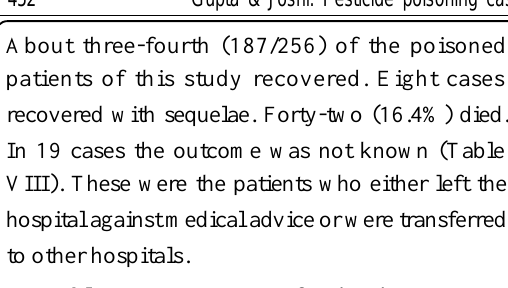
Table VIII : Outcome of poisoning cases attending different